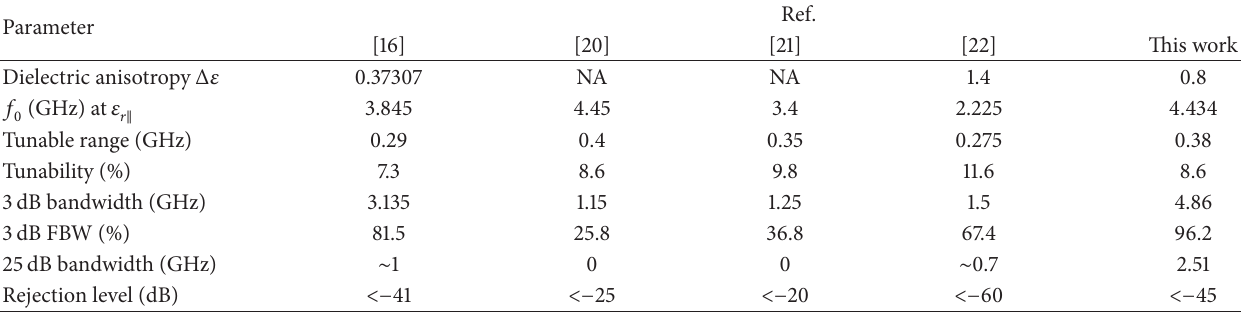
Table 3: Comparison with recently reported LC based tunable